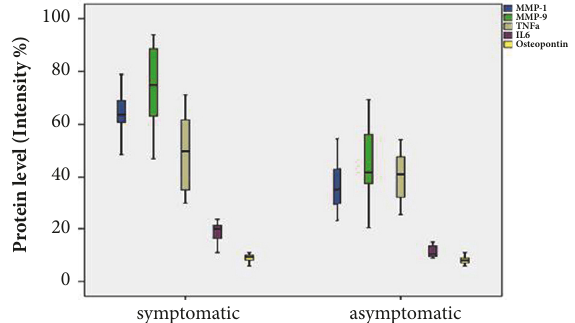
Figure 7: Boxplot of the mean values of the protein levels of all the biomarkers for symptomatic and asymptomatic